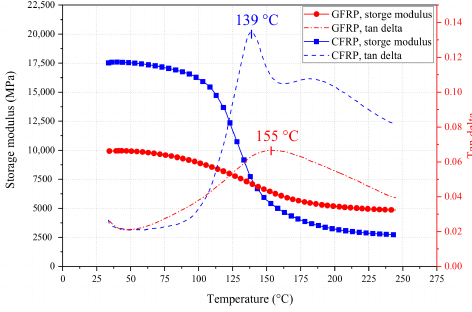
Figure 2. DMTA curves of GFRP and CFRP